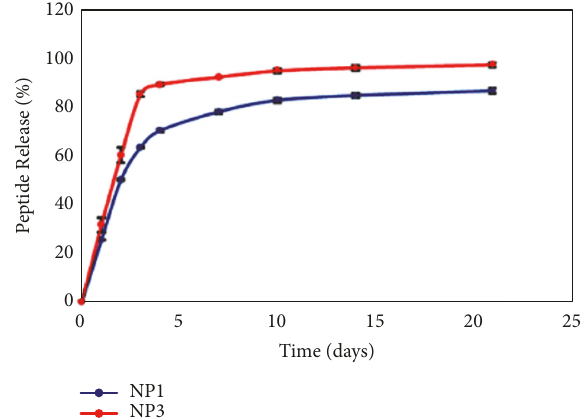
Figure 3: In vitro release profile of peptide from PLGA-PEG nanopar- ticles . Graphical representation of in vitro release of PLGA-PEG P1 and PLGA-PEG P3 plotted as a function of percent peptide release versus days from PLGA-PEG nanoparticles. The graph represents one of the two experiments